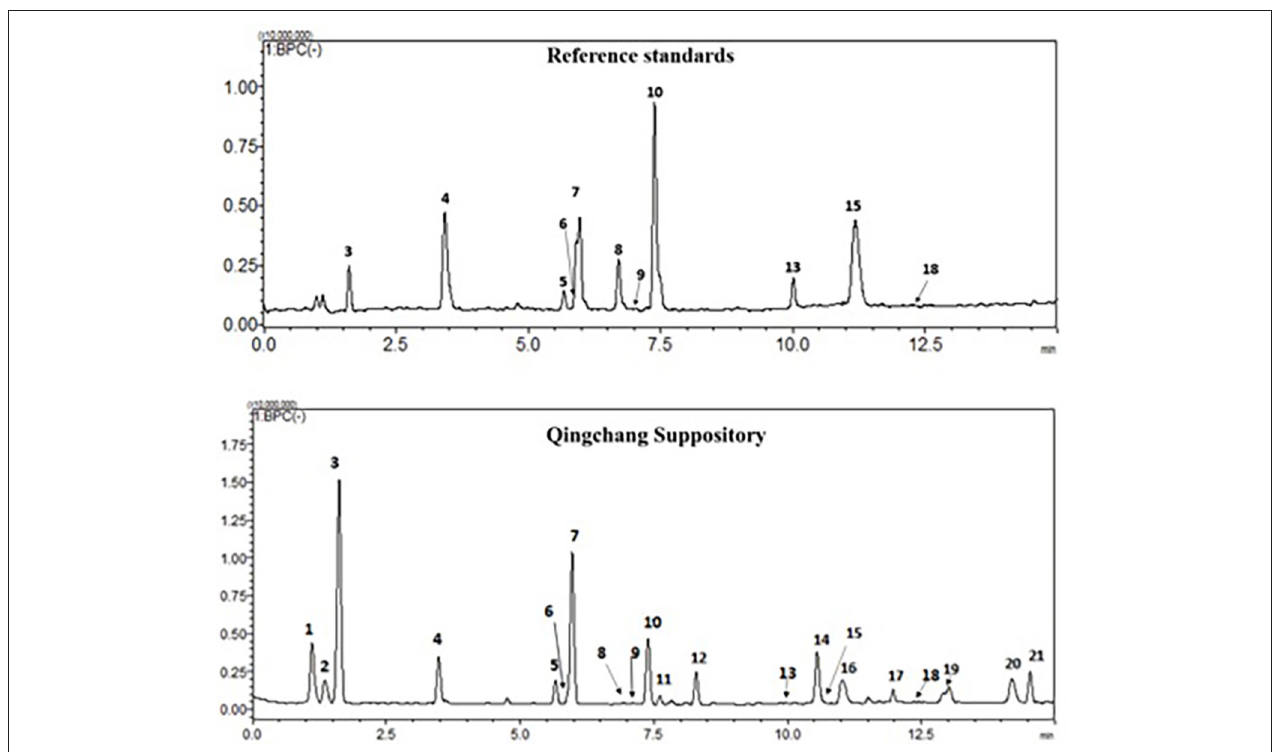
FIGURE 1 | Typical chromatogram of QCS in negative ion mode by